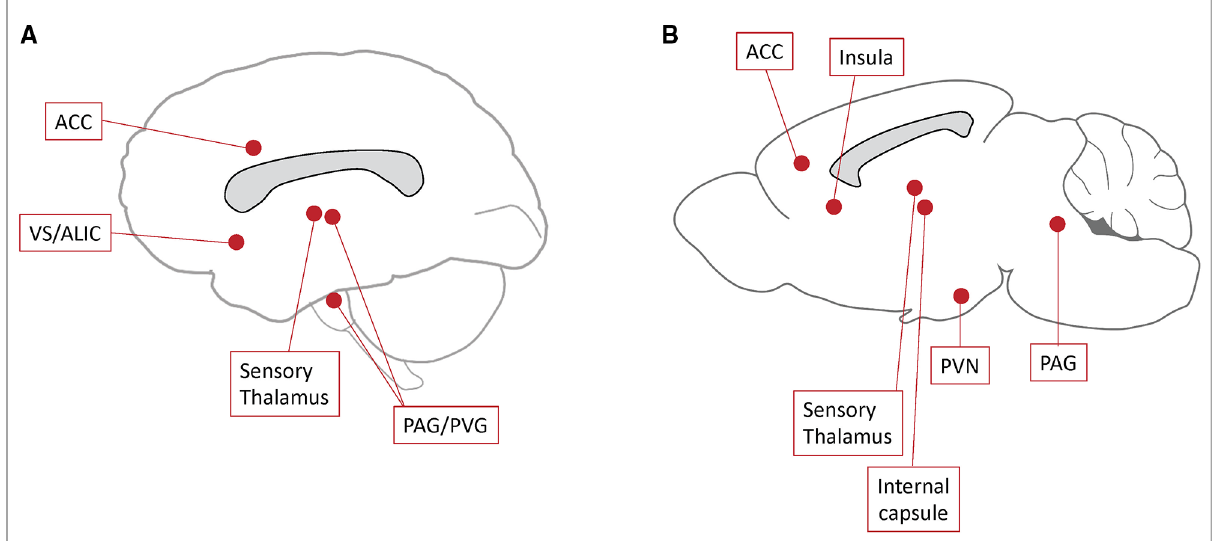
FIGURE 1 Deep brain stimulation (DBS) targets. Schematic representation of DBS targets studied in recent clinical trials ( A ) and preclinical models ( B ). ACC, anterior cingulum; PAG, periaqueductal gray matter; PVG, periventricular gray matter; PVN, paraventricular nucleus; VS/ALIC, ventral striatum/ anterior limb of the internal